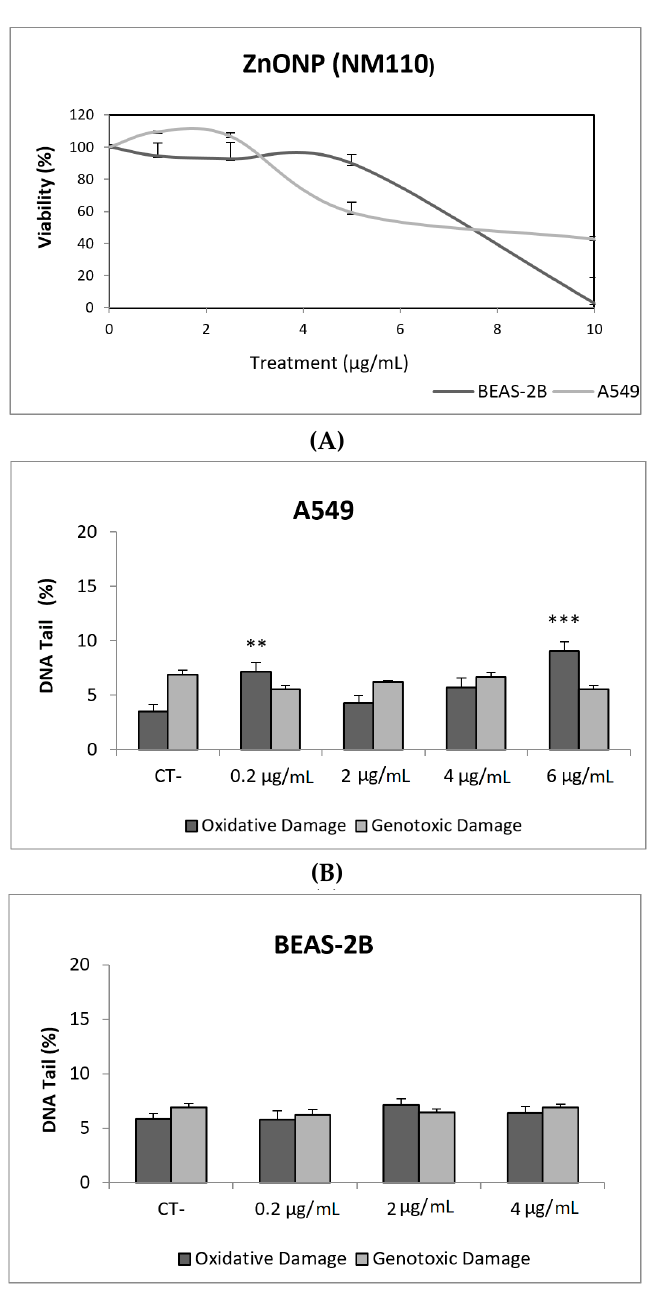
Figure 4. Results from the ZnONPs (NM110) on A549 and BEAS-2B cells. ( A ) Toxicity curves for both cell lines. ( B ) Genotoxicity results obtained in A549 cells. ( C ) Genotoxicity results obtained in BEAS-2B cells. Genotoxicity data are plotted as mean ± SEM of two independent experiments. ** p ≤ 0.01, *** p ≤ 0.001 (one way-ANOVA). CT, control.